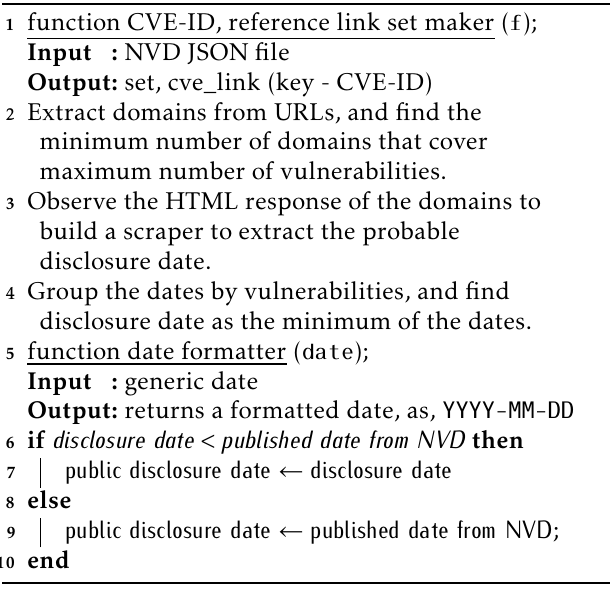
Algorithm 1: Finding the public disclosure